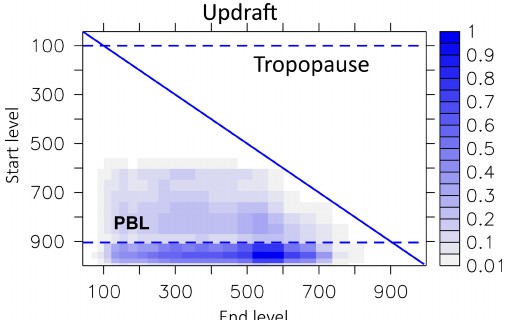
Figure 16. Movement characteristic of parcels transported in the updraft in 1997. The vertical axis describes the start level of a par- cel, and the horizontal axis describes the respective final updraft (end) level. Displayed are the respective numbers of parcels trans- ported in the updraft, normalised with the maximum number.